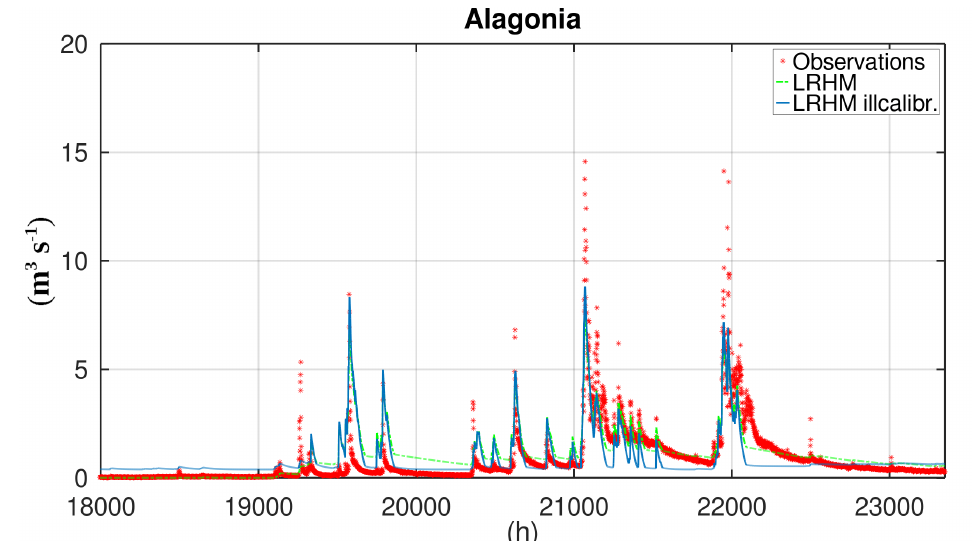
Figure 3. Application of LRHM in Alagonia during its calibration period, corresponding intentionally ill-calibrated LRHM model and